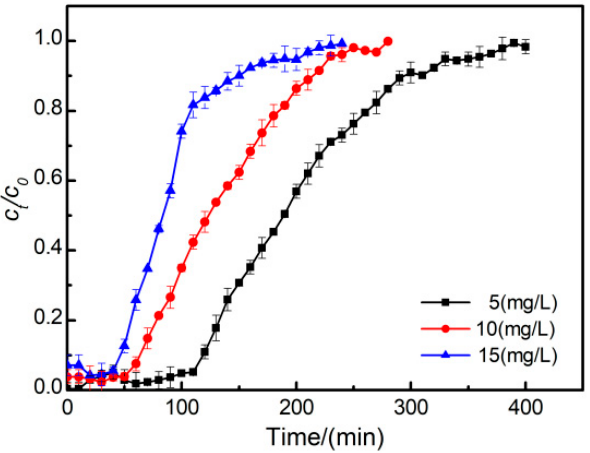
Figure 6. Effects of flow rate on breakthrough curves.